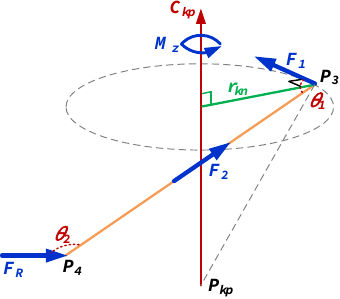
Figure 5. Relation between tire turning force and rack force .